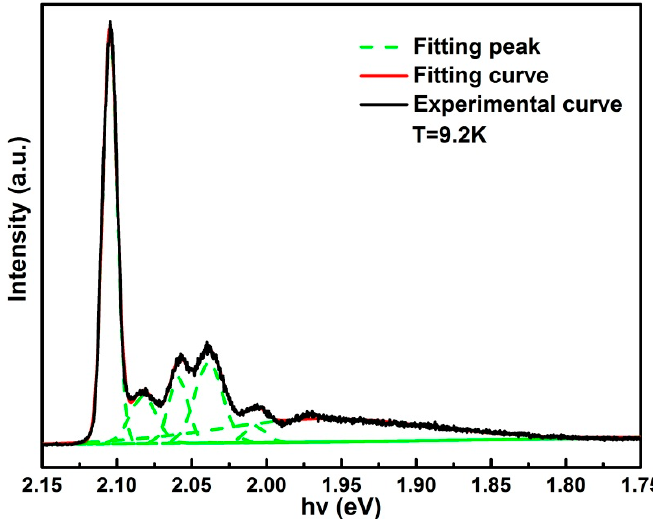
Figure 4. Typical PL spectrum of as-grown GaSe crystals at 9.2 K.